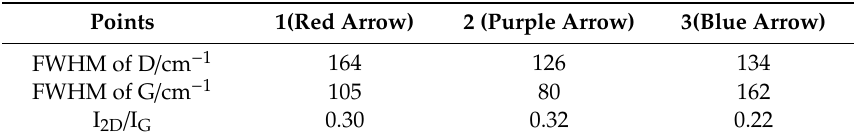
Figure 3. ( a ) Raman spectra of NGFs at the position marked by the red arrow. ( b ) Raman spectra of NGFs at the position marked by the purple arrow; ( c ) Raman spectra of NGFs at the position marked by the blue arrow; ( d ) transmittance of NGFs. Table 2. Linewidth of D and G peaks and Raman intensity ratios of 2D and G peaks (I 2D / I G ). FWHM: full width at half